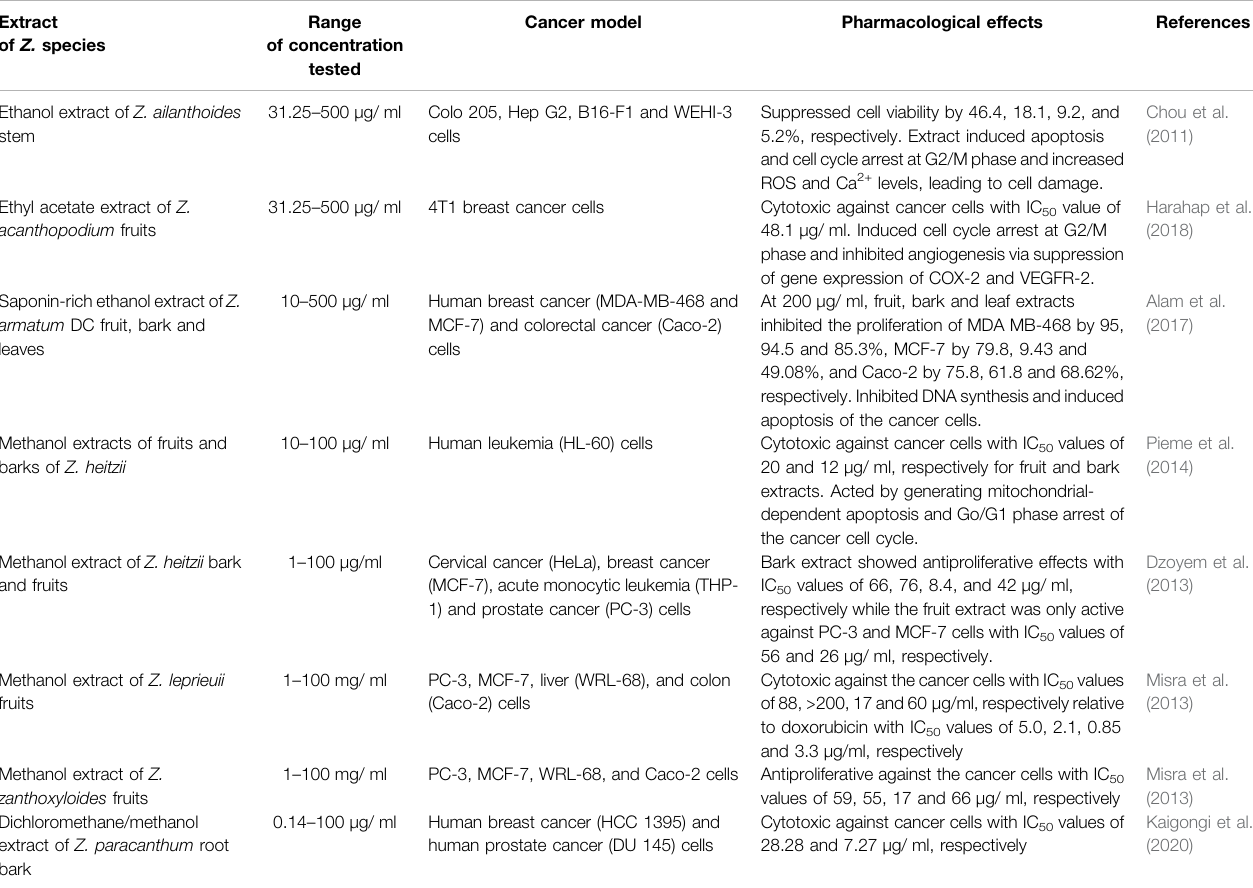
TABLE 1 | Summary of in vitro anticancer properties of Z. species extracts. Extract of Z.